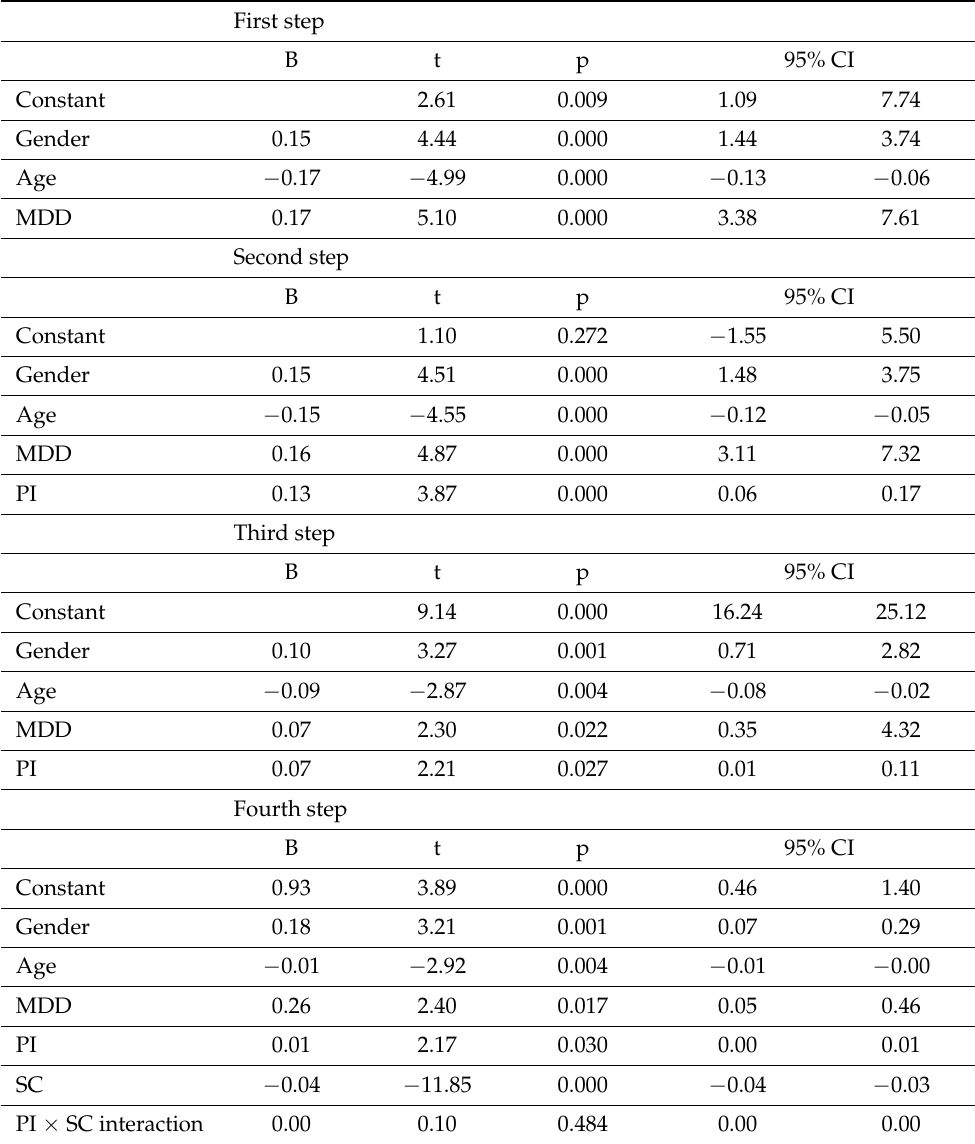
Table 2. Hierarchical regression analysis showing the prediction of DASS-21 total score by sociode- mographic and psychological